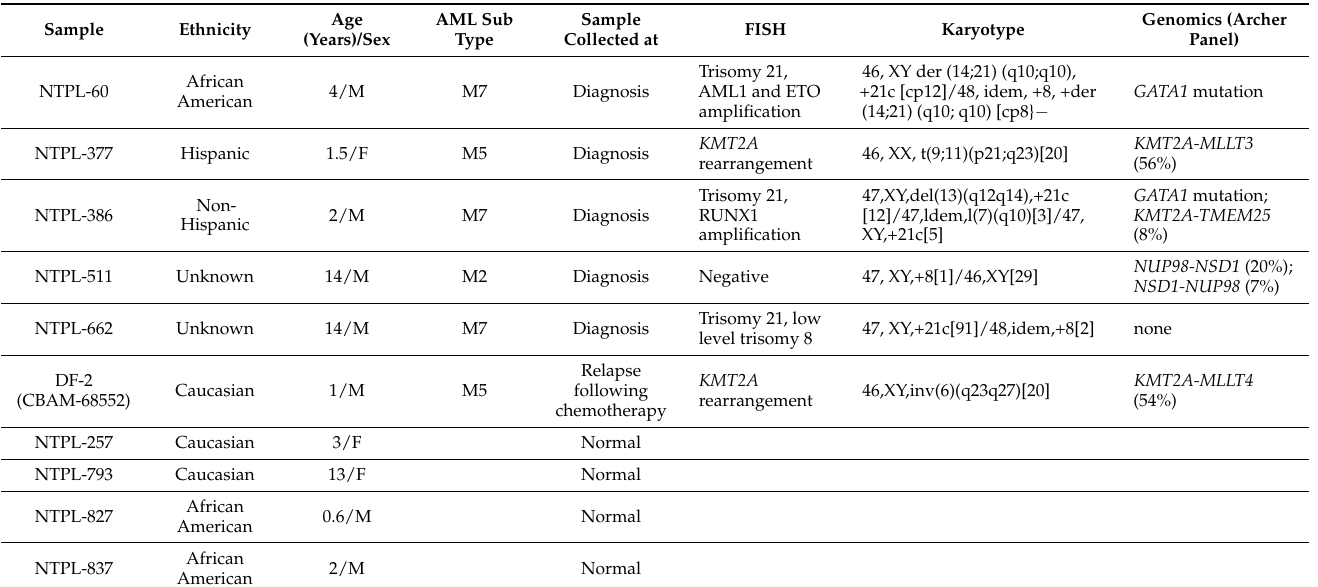
Table 1. Patient demographics, characteristics, and cytogenetics of pediatric AML PDX